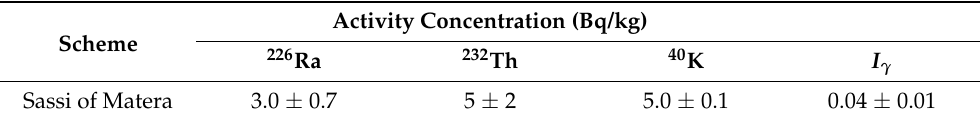
Table 2. Mean values of activity concentration of the analyzed radionuclides and I γ .